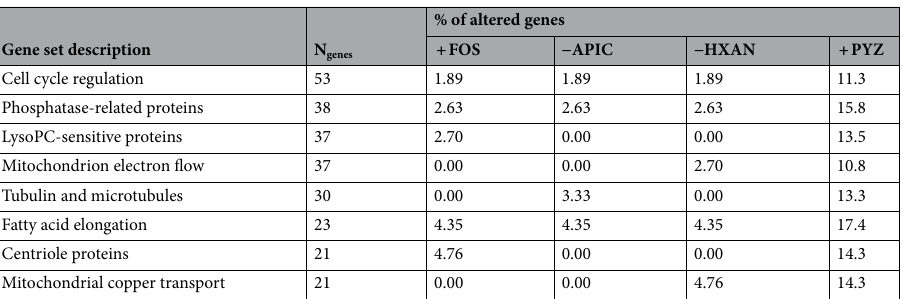
Table 1. Gene sets altered only in pyrazoleamide-treated parasites (We mapped Plasmodium genes, with |FC gene |≥ twofold, onto 509 gene sets in the Malaria Parasite Metabolic Pathway database 18 ). APIC apicoplast- disrupted parasites 19 , + FOS , fosmidomycin-treated parasites 11 , -HXAN hypoxanthine-limited parasites 12 , LysoPC lysophosphatidylcholine, + PYZ pyrazoleamide-treated parasites. FC gene denotes fold change in average expression of a gene due to the perturbation relative to its average expression under normal conditions (see “Materials and